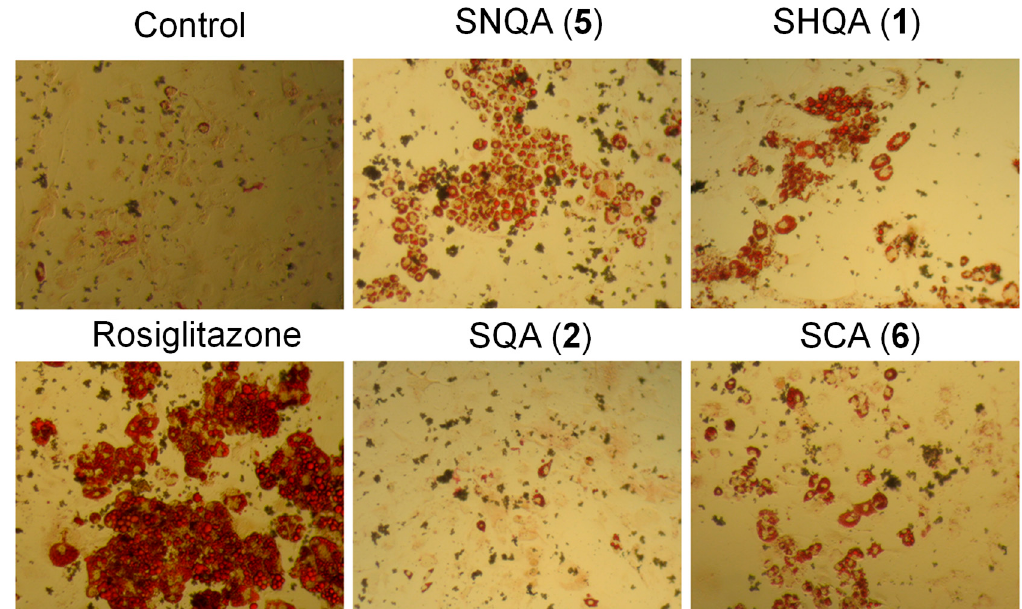
Figure 4. Representative images of oil red O stained 3T3-L1 cells after treatment with sargahydroquinoic acid ( 1 ), sargaquinoic acid ( 2 ), sarganaphthoquinoic acid ( 5 ), sargachromenoic acid ( 6 ) and rosiglitazone. Original magnification 200 ×.